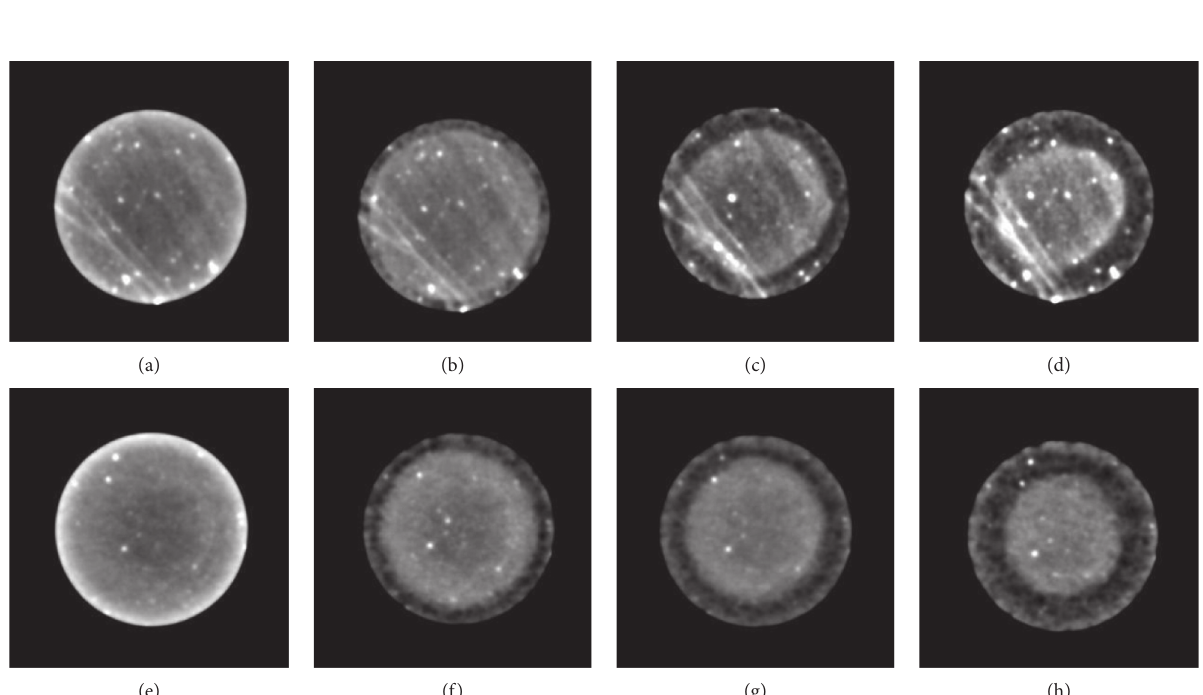
Figure 10: CT images of the middle layer of sandstone specimens subjected to different solutions for different stages: (a) pH � 3 H days), (b) pH � 3 H 2 SO 4 (30 days), (c) pH � 3 H 2 SO 4 (90 days), (d) pH � 3 H 2 SO 4 (180 days), (e) pH � 1 HCl (0 days), (f) pH � 1 HCl (30 days), (g) pH � 1 HCl (90 days), and (h) pH � 1 HCl (180 days).